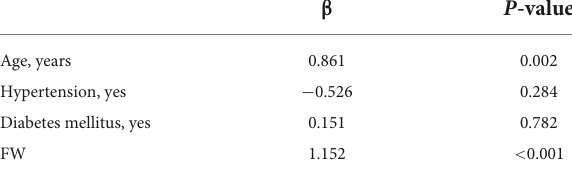
TABLE 3 Multivariate analysis for burden of cerebral small vessel